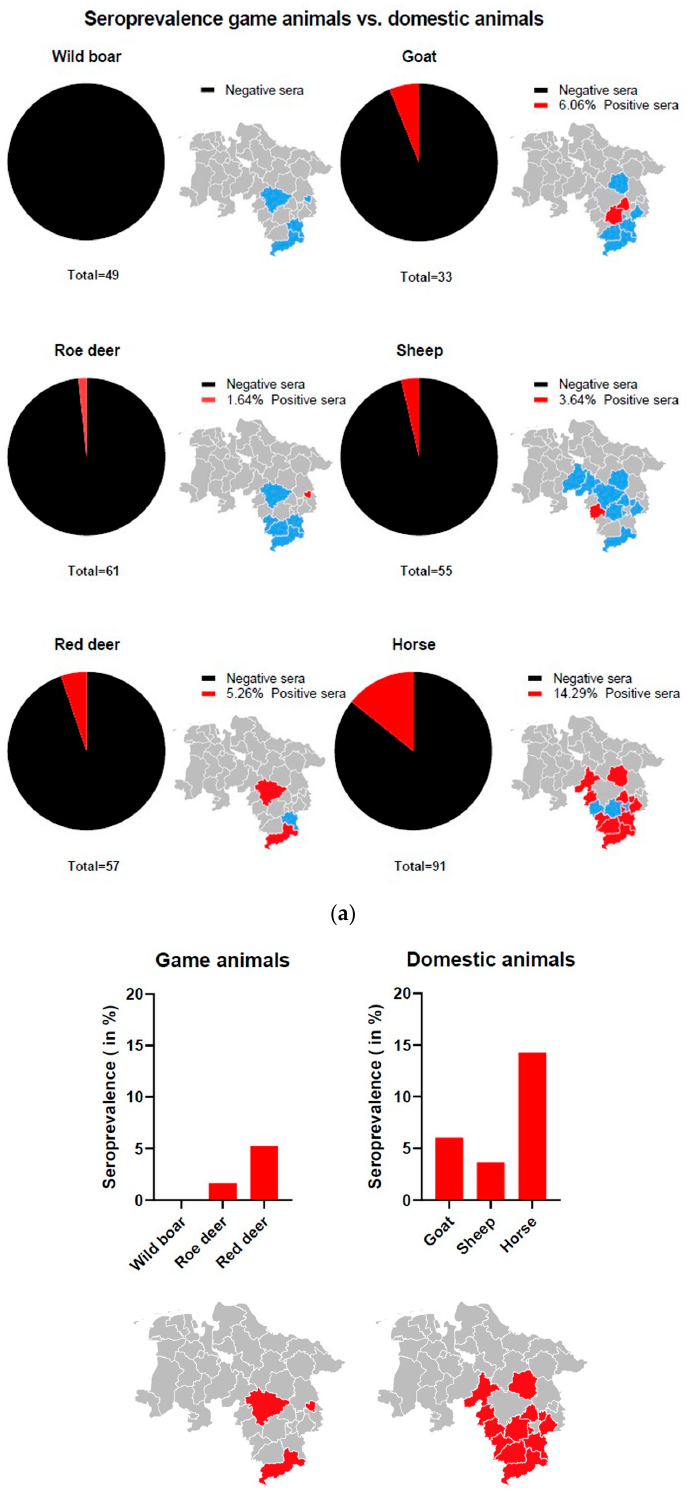
Figure 3. ( a ) Seroprevalence of wild and domestic animals based on LIPS data (red: positive serum sample(s) in this area; blue: serum samples screened in this area; grey: not screened); ( b ) overall seroprevalence of domestic or wild animals. Detailed map information in Figure S1. Maps were created in R v. 4.1.0 with administrative boundaries retrieved from the Global Administrative Areas Database